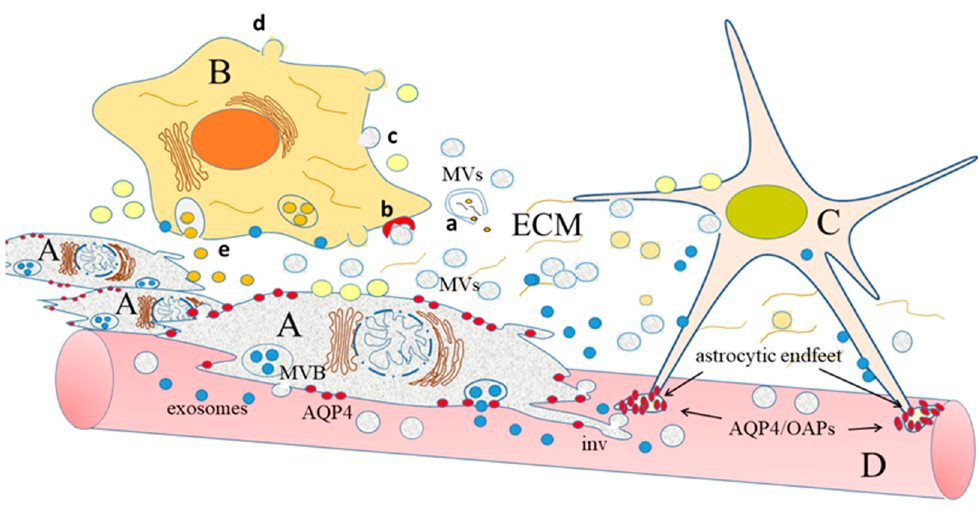
Figure 1. Cross-talk between glioma cells ( A ) and other cells ( B , C ), embedded in the extracellular matrix (ECM). The glioma cells have acquired the ability to move through the brain parenchyma, along the blood vessels ( D ), in small groups (guerrilla war) [23]; their invasiveness is mostly due to the extension of invadopodia (inv) and to the release of different kinds of extracellular vesicles: (i) membrane vesicles (MVs), light grey, which originate by directly budding from the plasma membrane and (ii) exosomes, blue, which are released after fusion with the plasma membrane of multivesicular bodies (MVB), components of the endosomal compartment. Both kinds of vesicles are equipped with different molecules (lipids, proteins and RNAs od different classes), which can be directly released into ECM if the vesicles break outside the cells ( a ). Alternatively, EVs can be bound by receptors present on the recipient cells ( b ), or fuse with the plasma membrane of these cells ( c ). Cells that receive information from glioma cells can, in turn, produce MVs, light yellow ( d ) and exosomes, dark yellow ( e ), which contain factors able to further stimulate glioma cell proliferation and invasion. In a normal astrocyte ( C ) AQP4 forms orthogonal arrays of particles (OAPs), localized in the cell endfeet (groups of small ovals drawn in red). In the glioma cell, AQP4 (red circles) is neither included in OAPs, nor localized; in addition, AQP4 levels are upregulated.